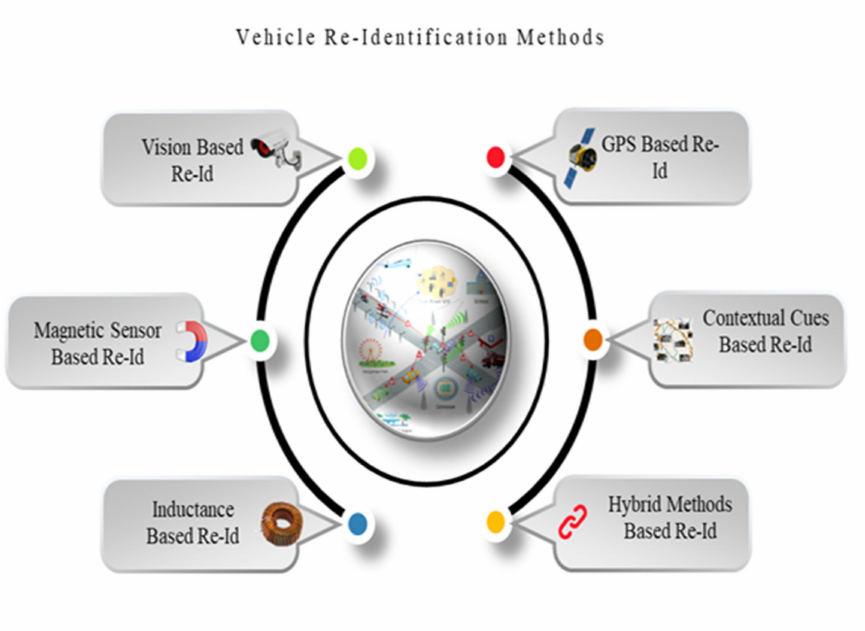
Figure 7. Shows vehicle re-id